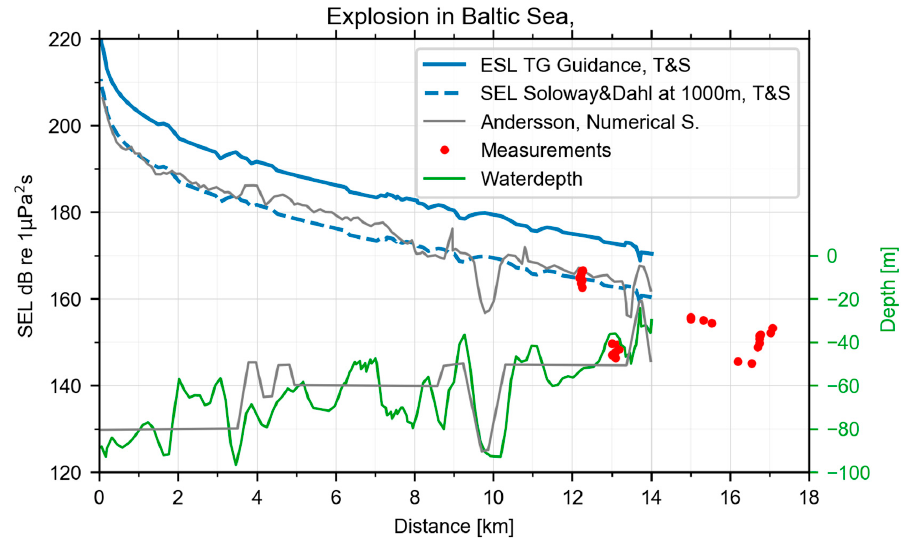
Figure 10. Comparison of modelled SEL over distance from both approaches with measurement results and with numerical results as published in [16]. For both approaches, the same Formula (1) and bathymetry was used for the noise propagation modelling. The blue solid line shows the result obtained by using the first approach for the source description according to TG Noise Guidance Part 3. The blue dashed line shows the result obtained by using the second approach according to Formula (2). Results of the numerical calculations with data from Andersson’s [14] including the bathymetry used are shown in grey.